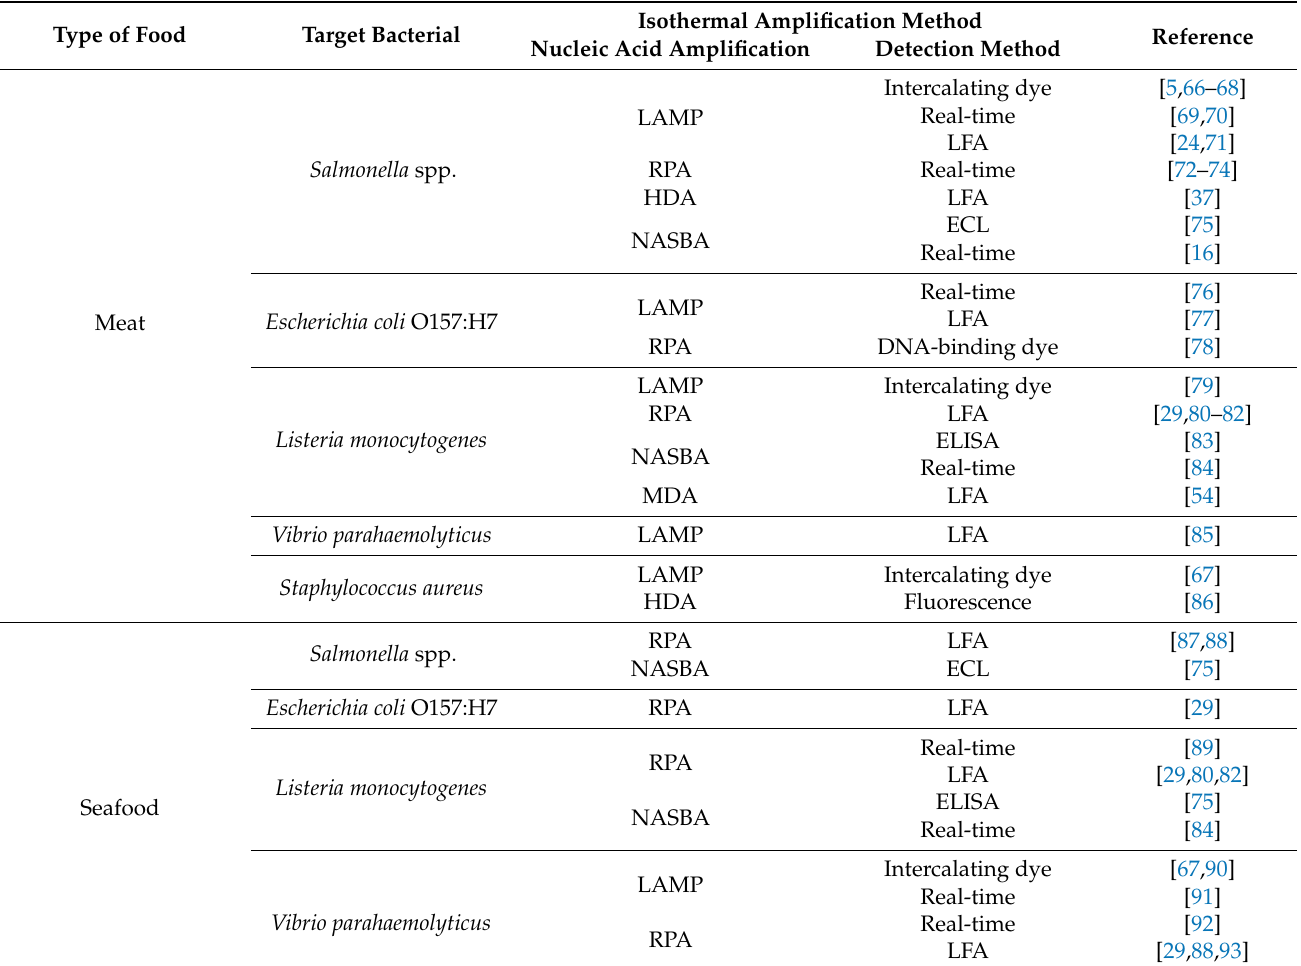
Table 2. Isothermal amplification processes used for detecting food-borne pathogens in foods. Type of